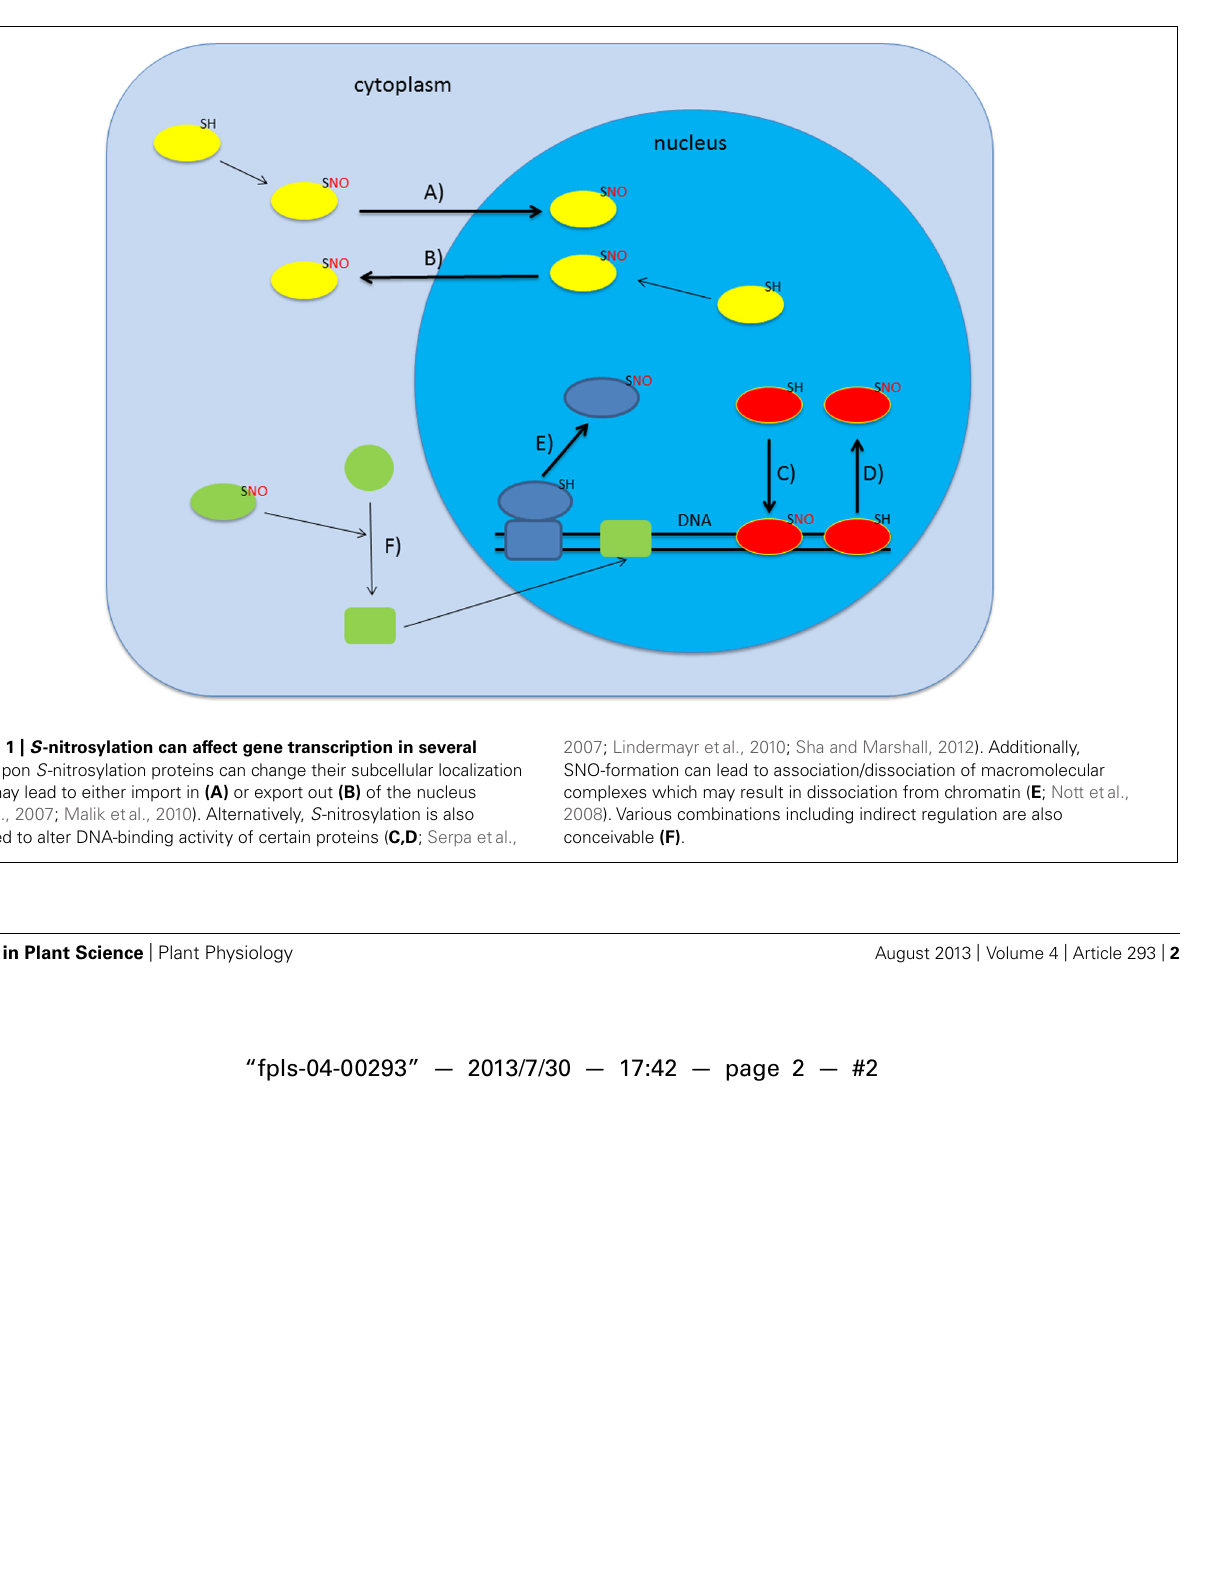
2007; Lindermayr etal., 2010; Sha and Marshall, 2012). Additionally, SNO-formation can lead to association/dissociation of macromolecular complexes which may result in dissociation from chromatin ( E ; Nott etal., 2008).Various combinations including indirect regulation are also conceivable (F)